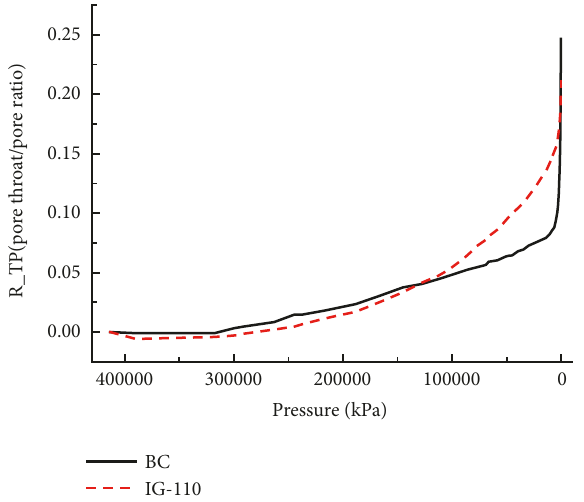
Figure 12: The 𝑅 𝑇𝑃 curves of BC and IG-110 in mercury extrusion